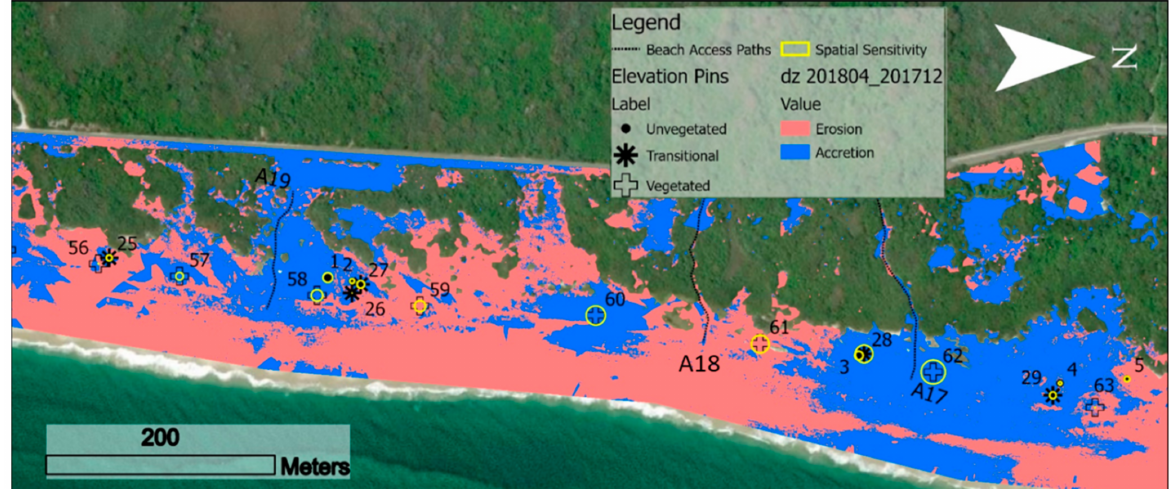
Figure 7. A zoomed view (accesses 19 to 17) of spatial sensitivity analysis showing measured buffers (yellow circles) around numbered elevation pins (symbols) overlain on a categorical ∆ z map from flights two to three, April 2018 to December 2017. Forested areas were masked and excluded. Only between flights two to three was there a difference in radii, with vegetated pins showing a wider radius than both the transitional and unvegetated areas (Kruskal–Wallis Test, x V = 4.57 ± 0.78; x T = 1.75 ± 0.47; x U = 1.37 ± 0.52; X 2 = 13.64, p = 0.001).